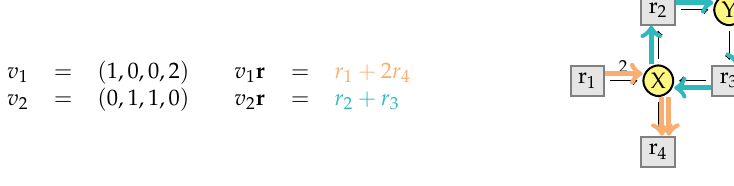
Figure 5. The elementary modes of the reaction network in Figure